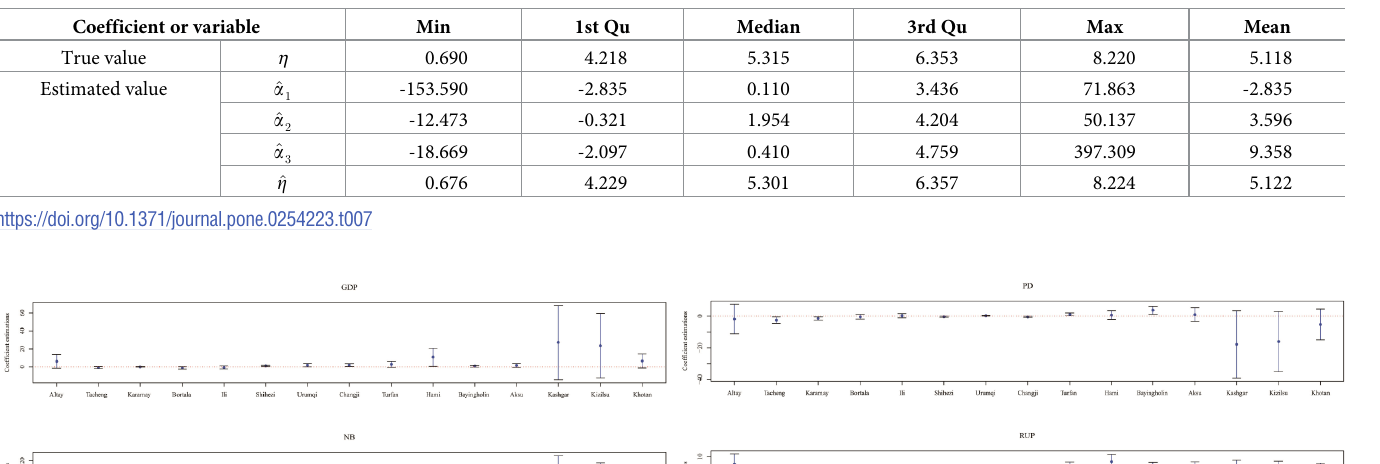
Table 7. Quantile and mean values of coefficient estimations and response variables.